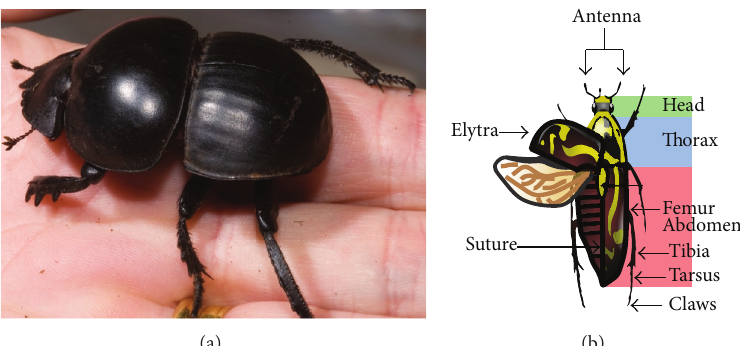
Figure 1: Summary figure showing two beetles. (a) Shows a dung beetle (photo: F.D. Duncan) and (b) shows the typical morphology of a beetle (see